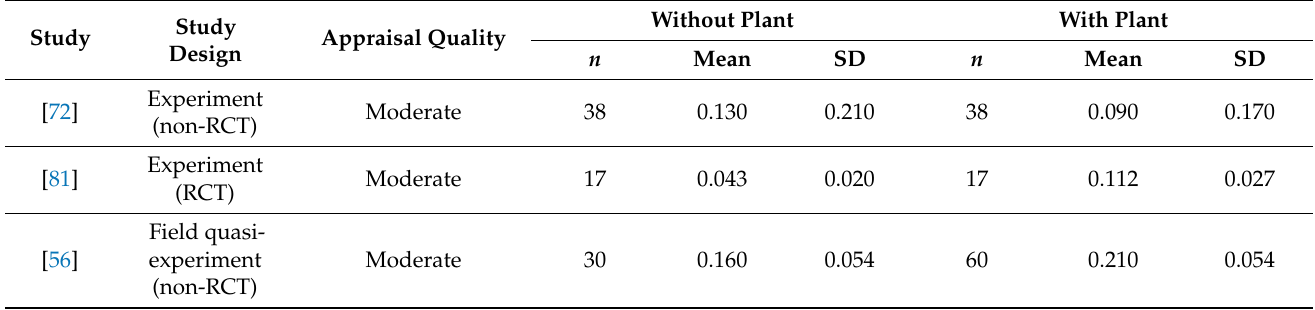
Table 10. Original data of the studies examining the influence of indoor plants on EEG α waves.